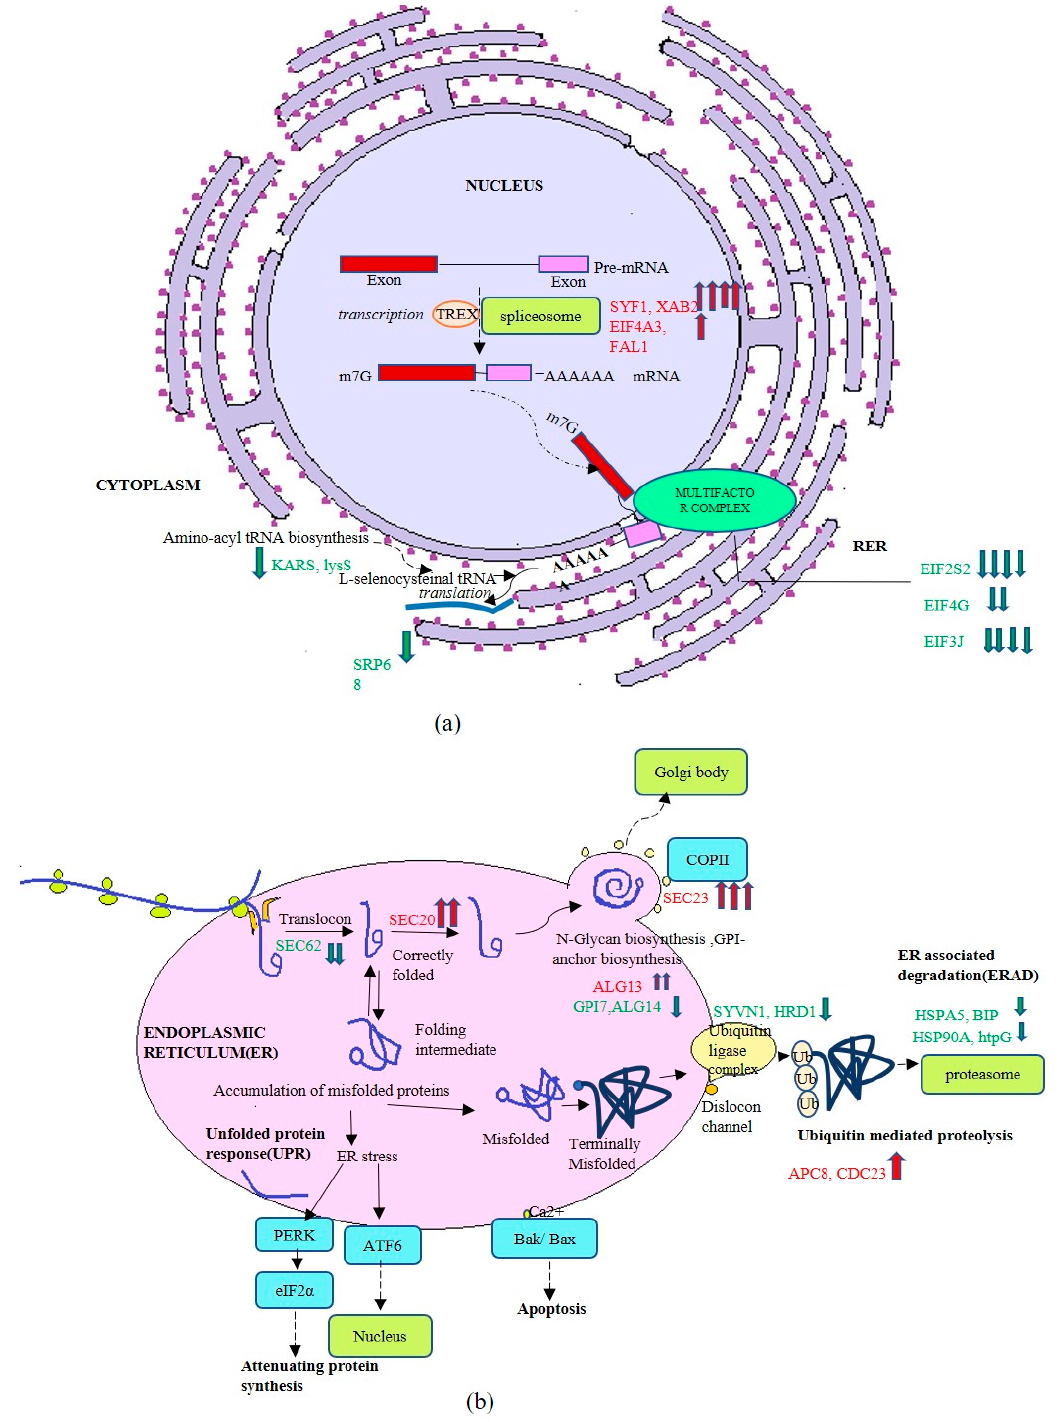
Figure 8. ( a ) Genes regulated in post-transcriptional pathway under optimized and unoptimized conditions. ( b ) Genes regulated in transport of protein to ER, folding and secretory pathway under optimized and unoptimized conditions.